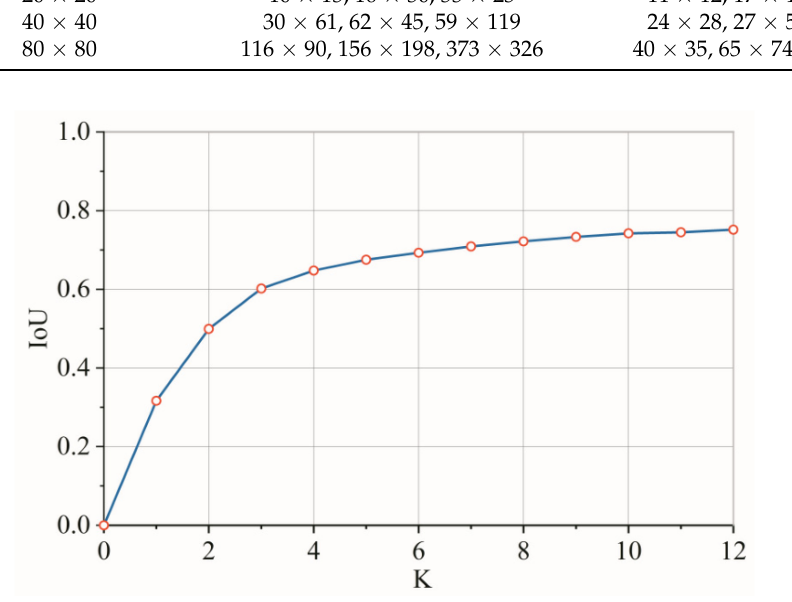
Figure 11. Variation curve of IOU with anchor frame k.